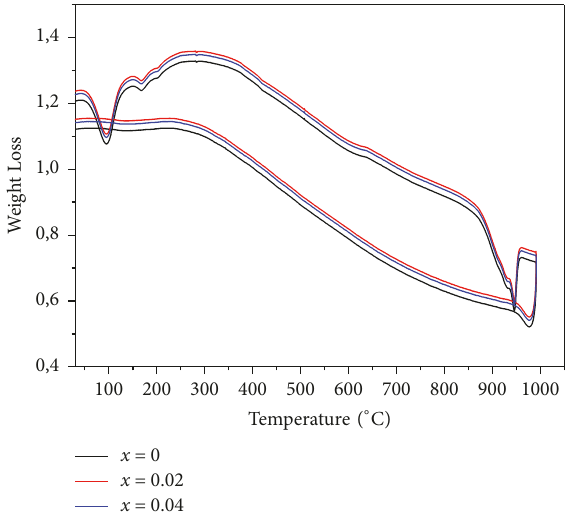
Figure 6: DTA of LiGd (1